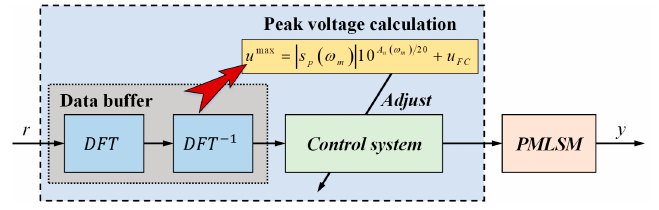
Figure 5. Implementation block diagram of AFOAM. As shown in Equation (20), we only need to adjust the amplitude characteristic at ω k